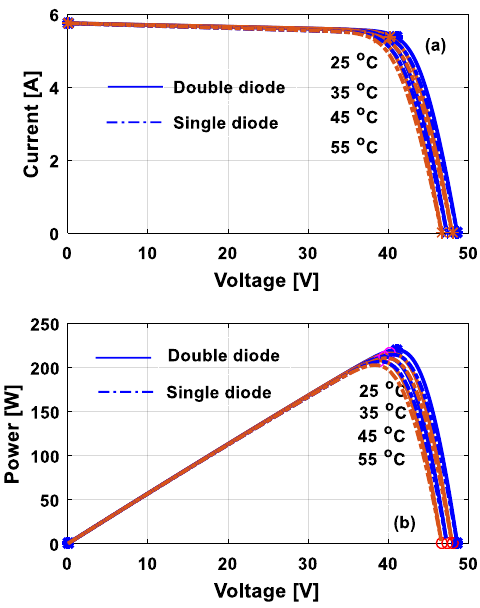
Figure 5. PV system: ( a ) I-V and ( b ) P-V characteristics at different temperature conditions.